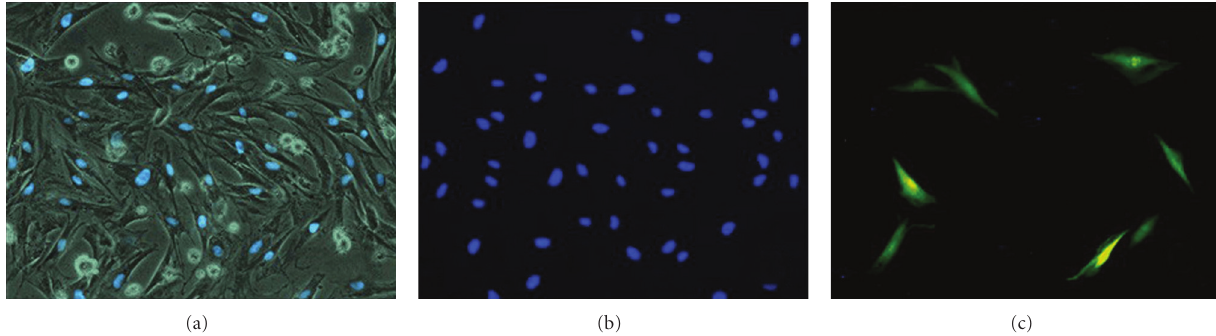
Figure 11: Transfecton e ffi cency = (The number of cells expressing green florescence/The number of cells expressing blue florescence) × 100%, and the average value obtained from 3 ∼ 4 visual field. (a) The cells type and Hoechst33342 stained nucleus that showed light blue under optical microscope. (b) Hoechst33342 can directly permeate the normal membrane and dye the DNA of viable cells, which showed the nucleus expressed blue fluorescence. (c) The cells transfected with HIF-1 α -pcDNA 3 . 1 /eGFP, showed green fluorescence with whole cell type.